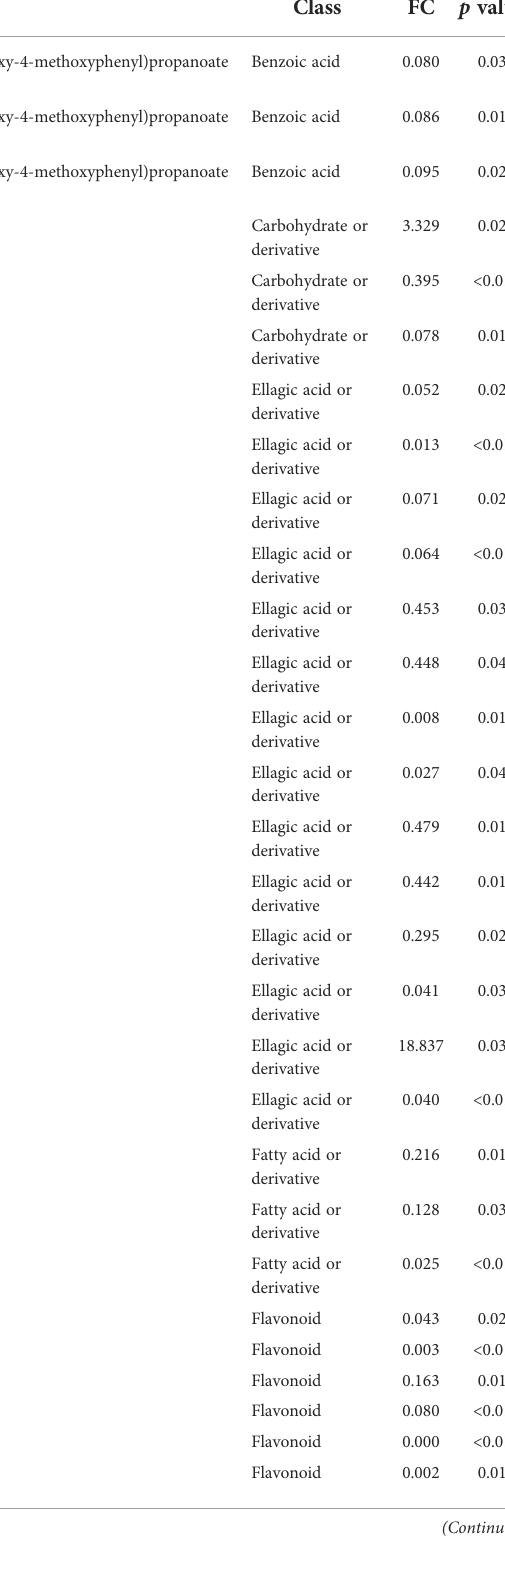
TABLE 2 Results of the ANOVA test for the evaluation of the effect of the trees ’ maturity in fresh and dried E. globulus leaf extracts [ p < 0.05; Fold change FC < -2: higher content in extracts prepared with leaves from young trees (YT); FC > 2: higher content in extracts prepared with leaves from mature trees